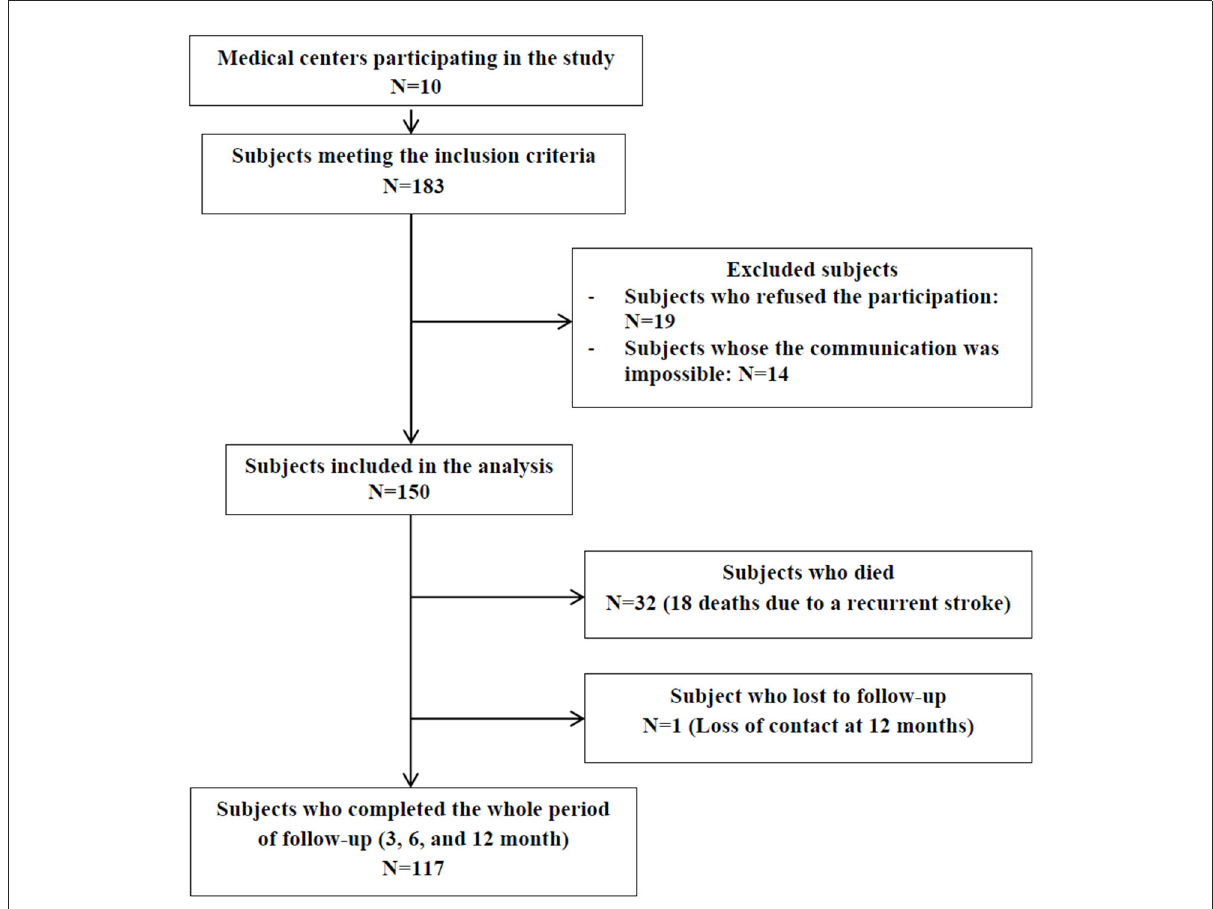
FIGURE1 Flow diagram of the steps followed to obtain the sample of the